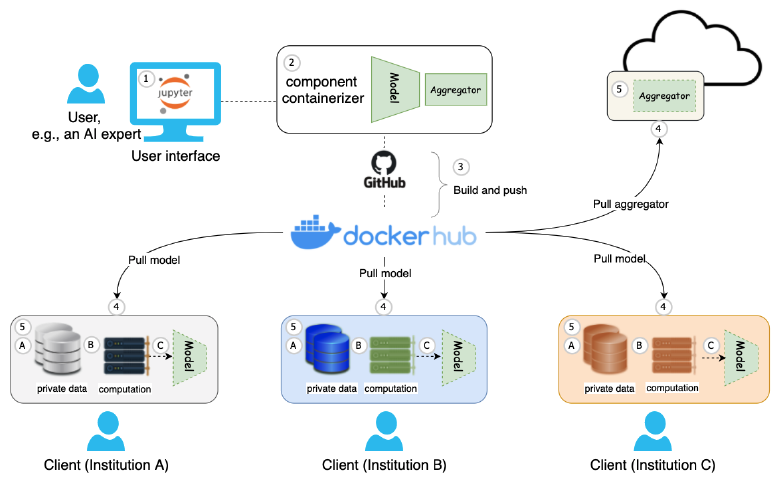
Figure 1. An overview of the architecture of Notebook Federator with NaaVRE